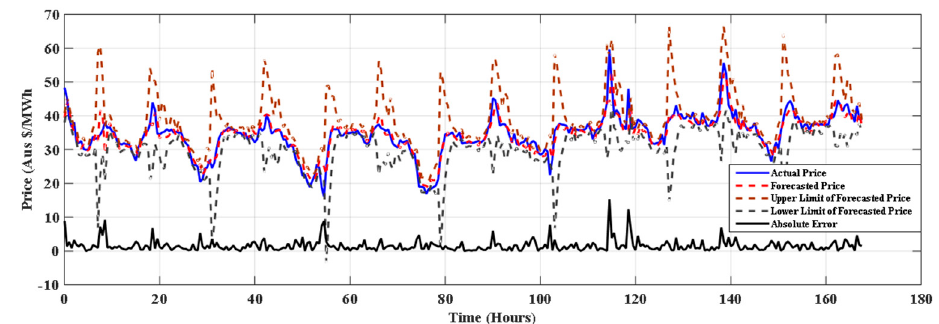
Figure 3. Forecasting for 22–28 August 2015 in winter with SMO